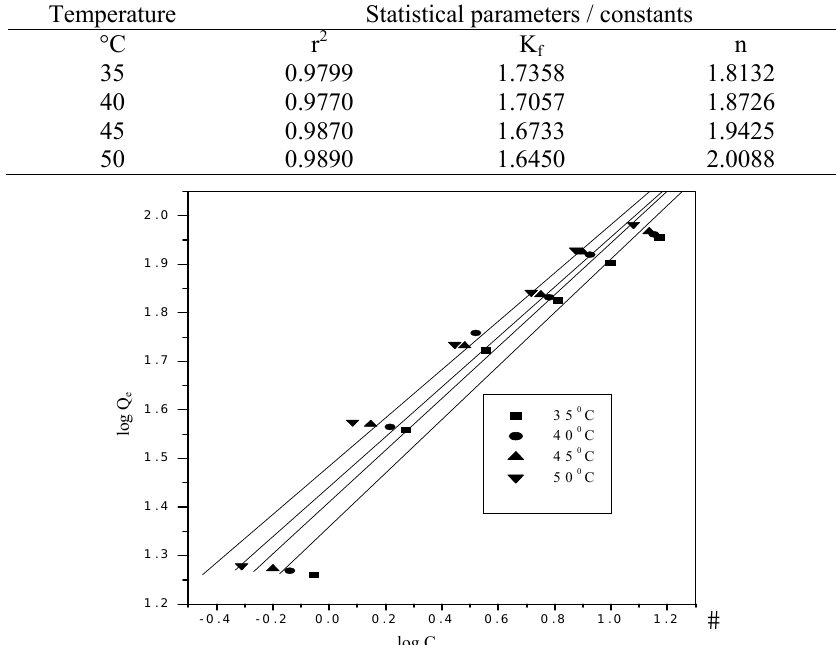
Figure 4. Liner Freundlich adsorption isotherm for copper